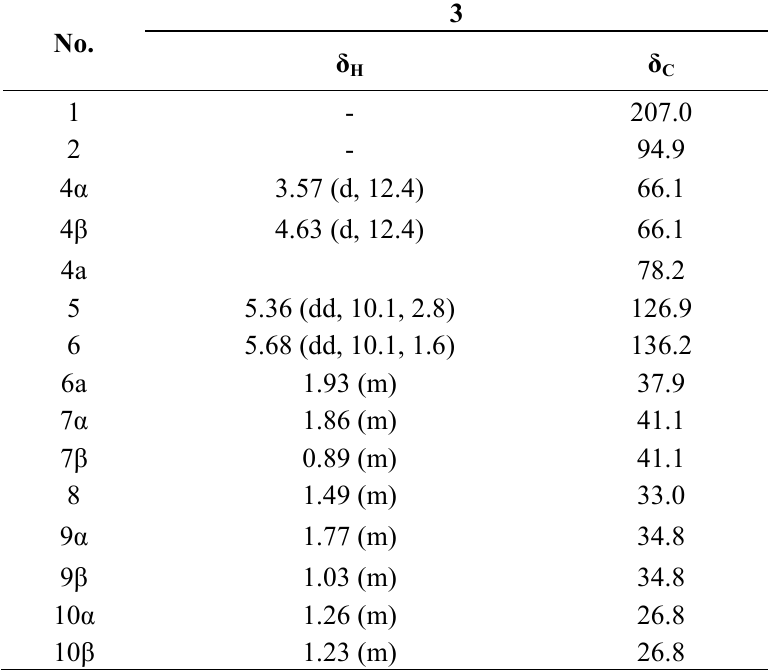
Table 2. 1 H- and 13 C-NMR spectroscopic data of compound 3 ( 3 at 600 MHz, CDCl chemical shift values are in ppm relative to TMS; multiplicity and J values (in Hz) are presented in